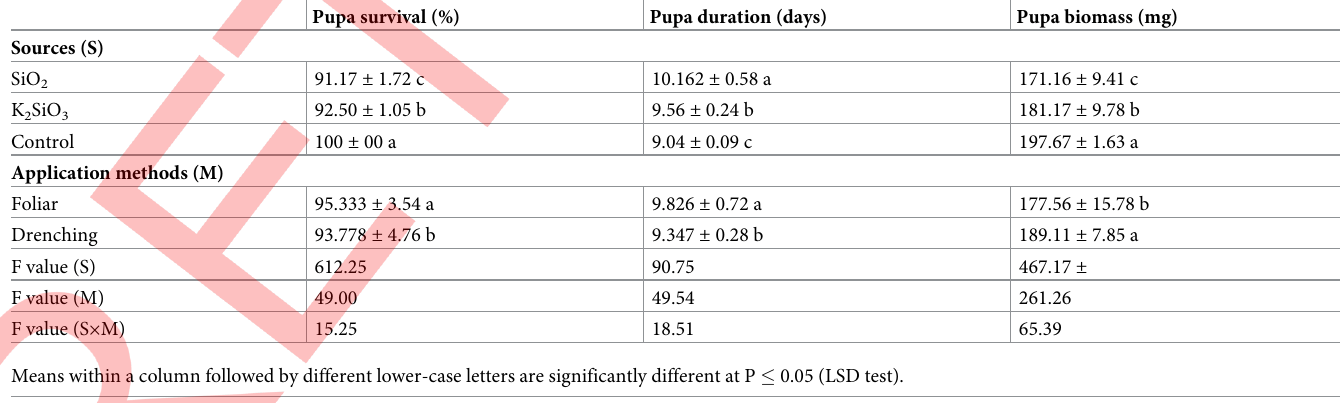
Table 2. Effect of silicon sources and silicon application methods on pupa survival percentage, pupa duration (days), and pupa biomass(mg) of fall armyworm feed- ing on maize plants. Pupa survival